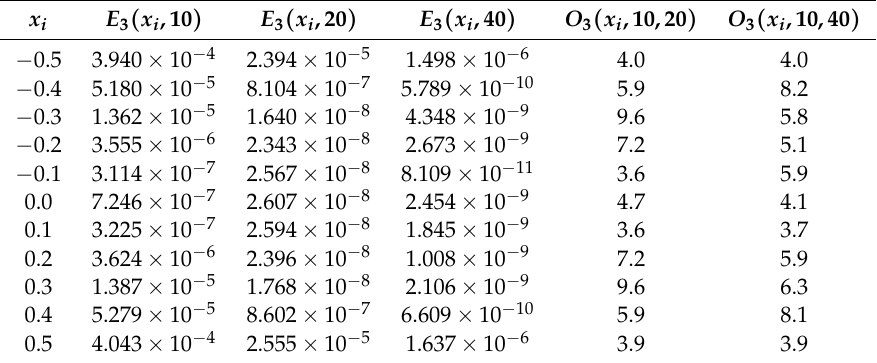
Table 11. The absolute errors of the third order derivatives of y 2 at the knots and the numerical convergence orders.